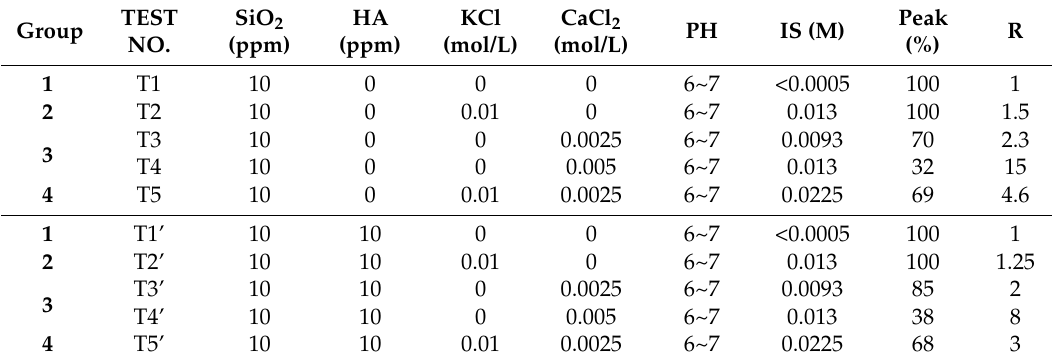
Table 1. Experimental conditions and results for column tests under different hydrochemical conditions.